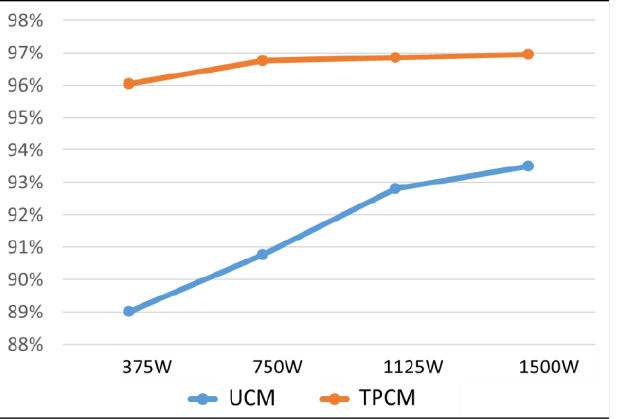
Figure 22. Power conversion efficiency of the H-bridge inverter under different output power and control modes .